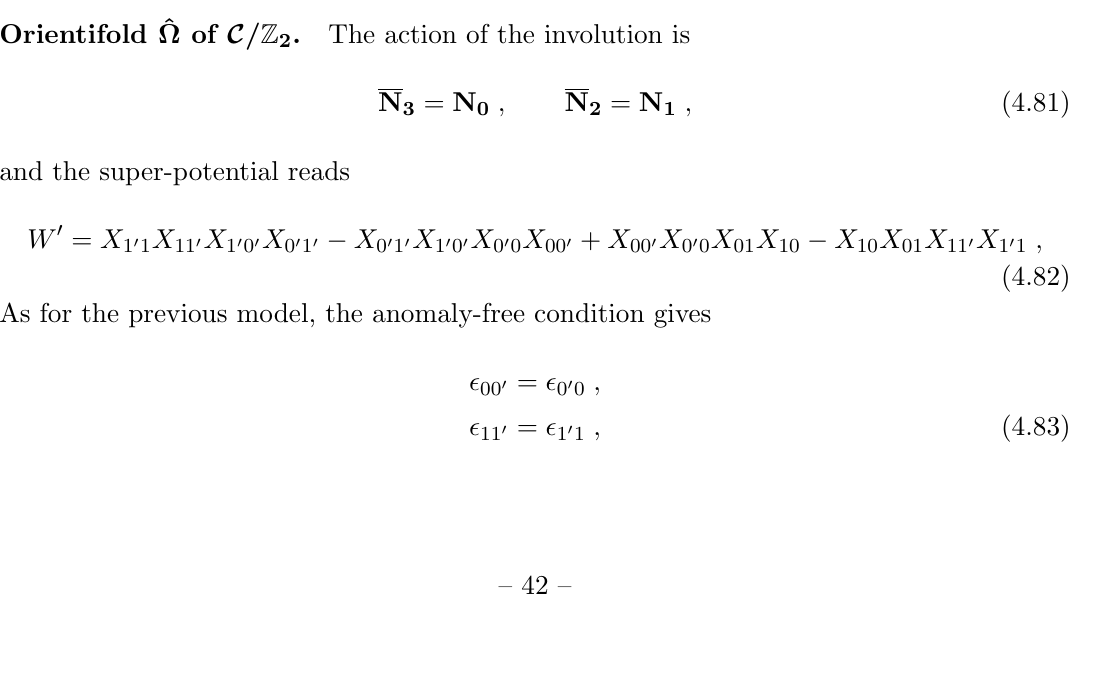
Orientifold ^(cid:10) of C = Z